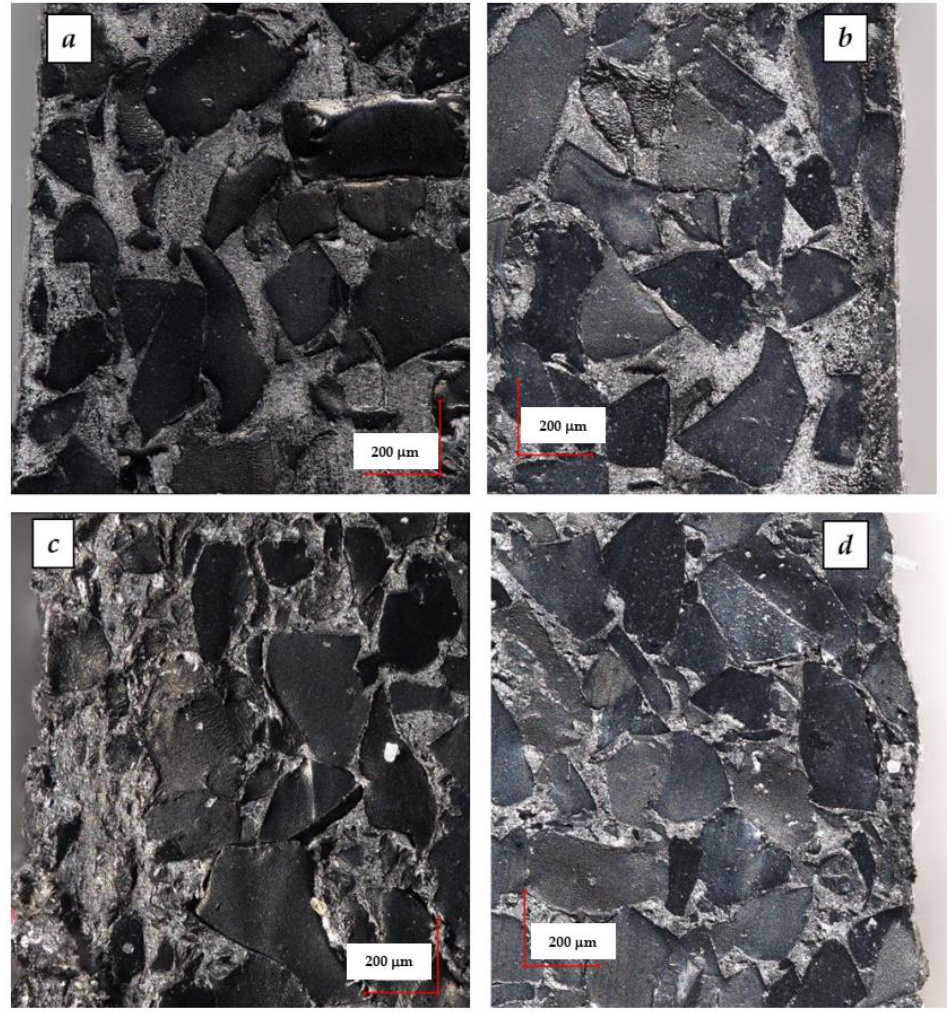
Figure 17. Photography of PP/GTR composites: PP/GTR70 ( a ), PP/GTR70-P ( b ), PP/GTR90 ( c ), PP/GTR90-P ( d ).